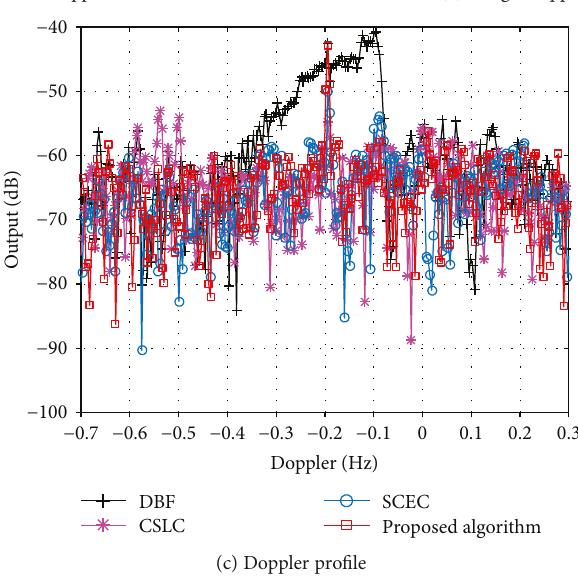
Figure 10: Comparison results for ionospheric clutter